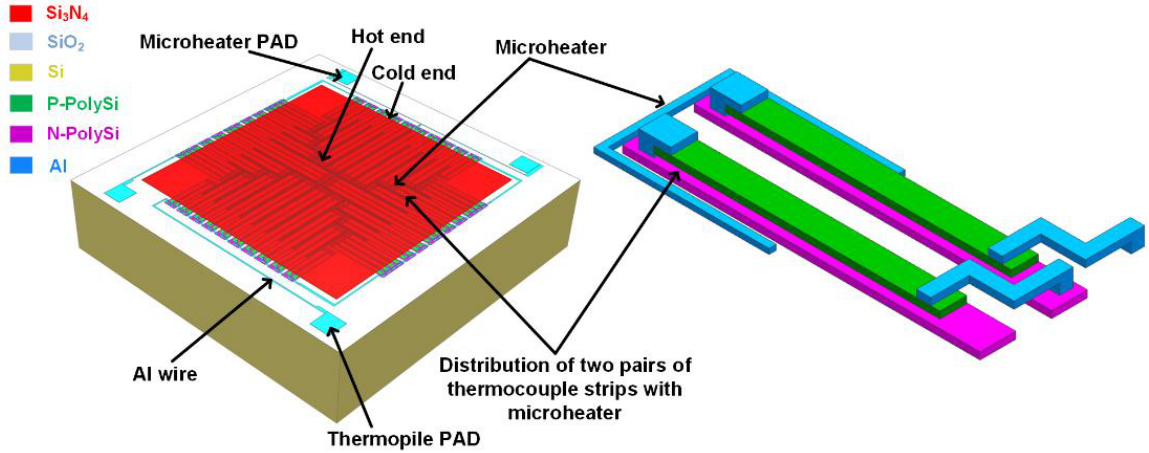
Figure 2. Schematic diagram of a MEMS thermopile with an embedded microheater.